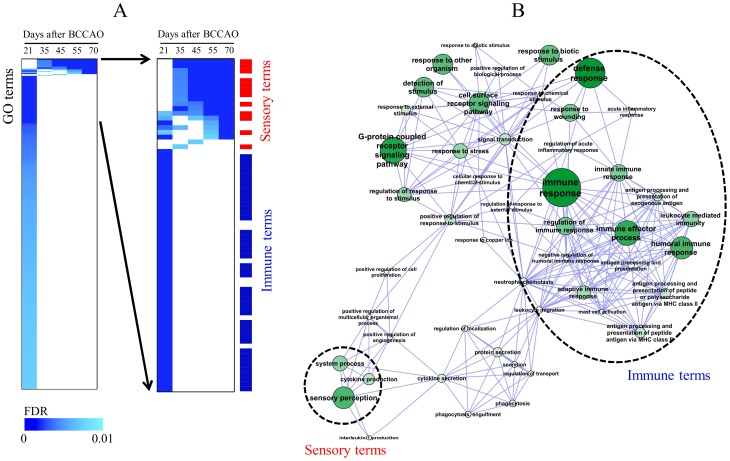
Distribution of altered Gene ontology (GO) terms in the hippocampus after BCCAO.(A) Differentially-expressed genes with a 2-fold increase and decrease at each time point after BCCAO were subjected to analysis using GoMiner. The columns represent individual samples, while the rows represent statistically significant GO categories (FDR<0.01). The statistical significance was represented in color gradient with a scale bar. The positions of the sensory or immune-related terms are indicated in a detailed view. (B) The network structure of non-redundant GO terms was constructed from all enriched GO terms at 21 and 70 days after BCCAO (FDR<0.01) using the REIVGO program. The node size and color thickness were proportional to the statistical significance of each node. The clusters of the sensory terms and immune terms are indicated in dotted circles.